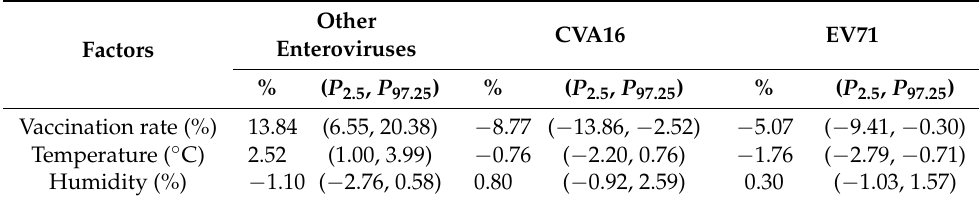
Table 4. Proportions changed in HFMD genotype frequency with each unit increase in vaccination rate and climate